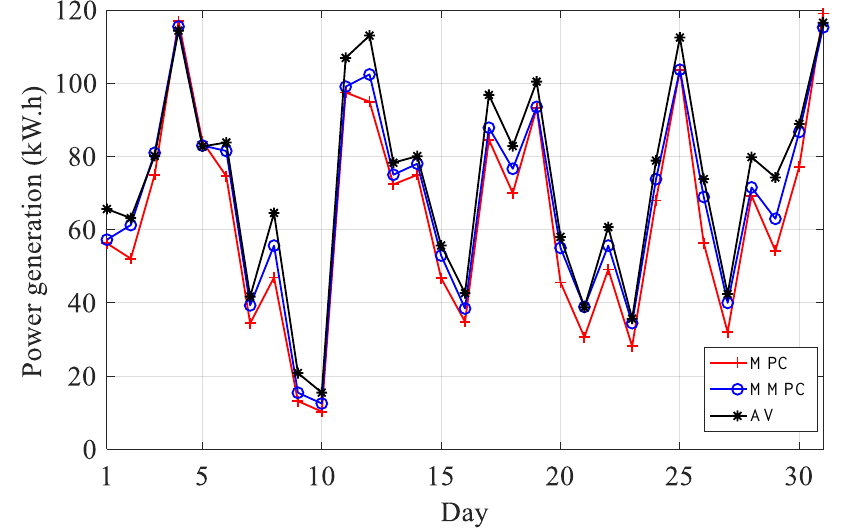
Figure 12. Comparison chart of Diurnal electric quantity.